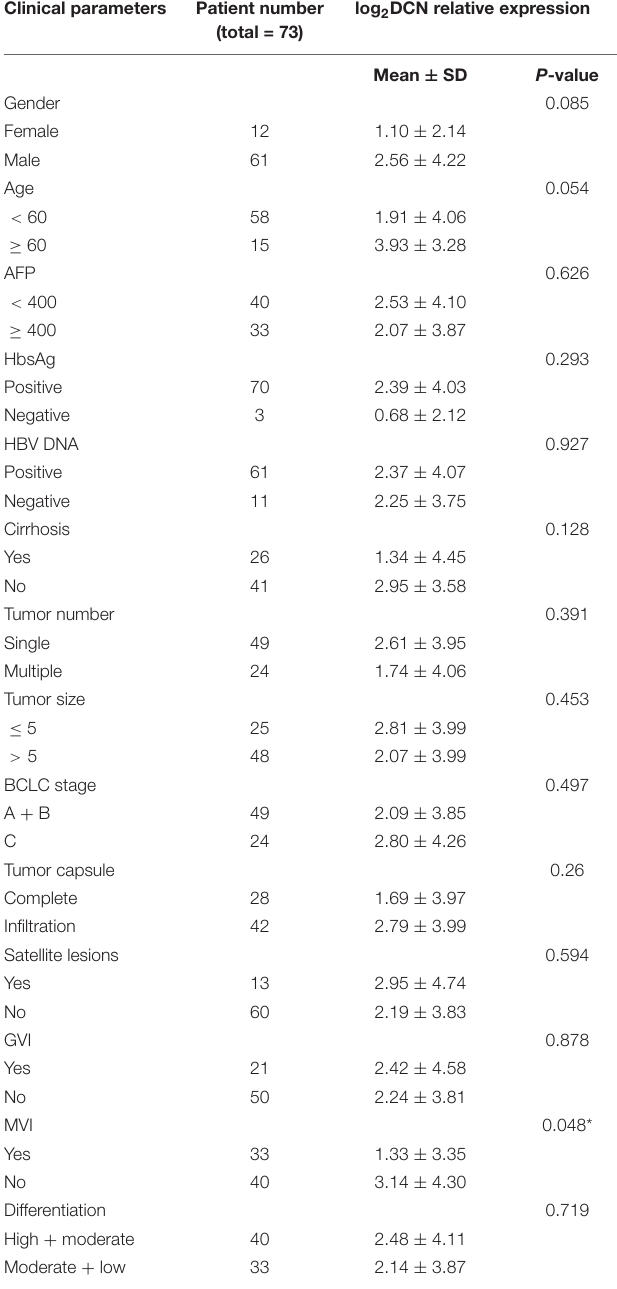
TABLE 2 | Relationship between the expression of decorin in tumor tissues and clinical characteristics of HCC patients. Clinical